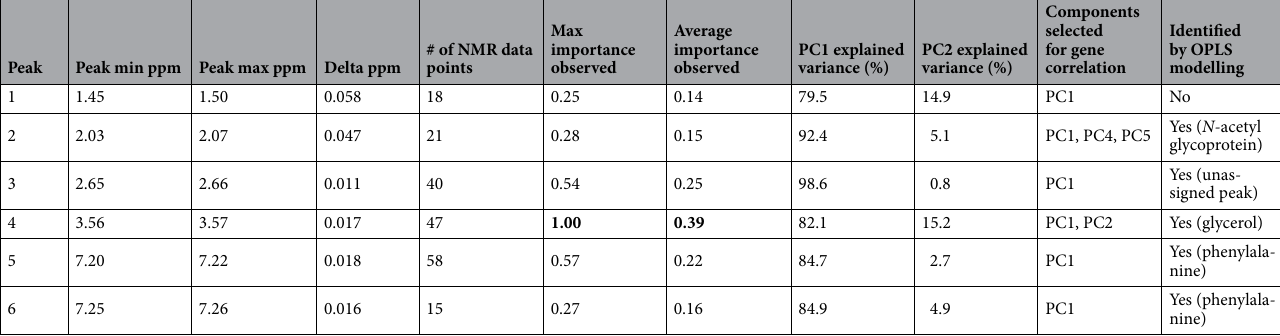
Table 4. Machine learning selected NMR peaks. Significant values are in [bold]. Peaks identified by the RF classifier in the discrimination of CD patients by their CRP status. Reported importance is scaled by the maximum importance